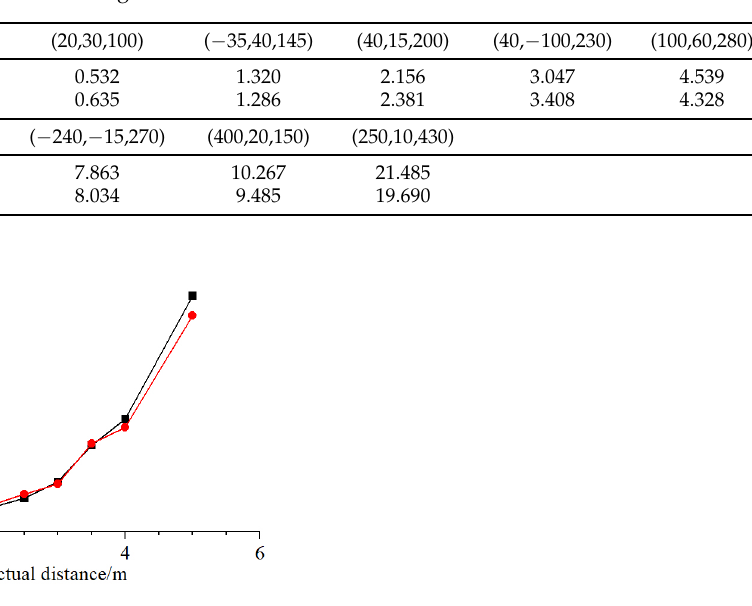
Table 4. Results of relative bearing estimation.